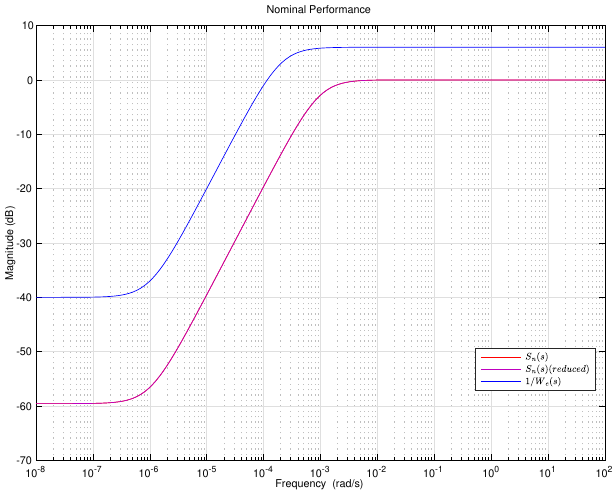
Figure 11. Nominal sensitivity analysis.